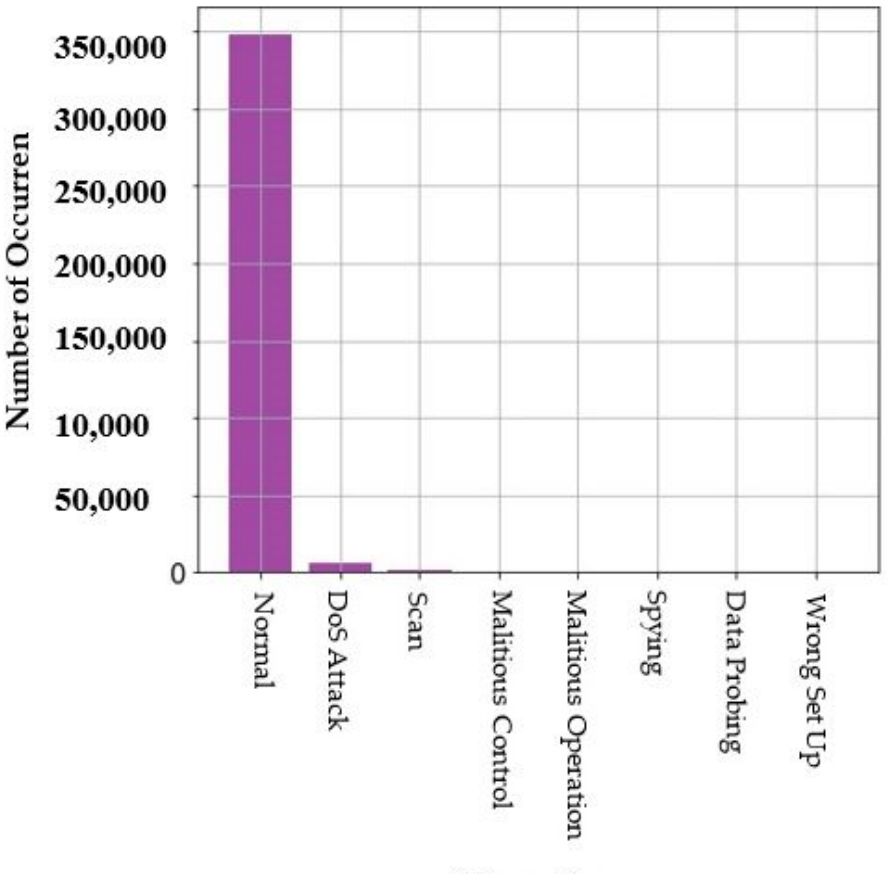
Figure 7. “Normality” column distribution.